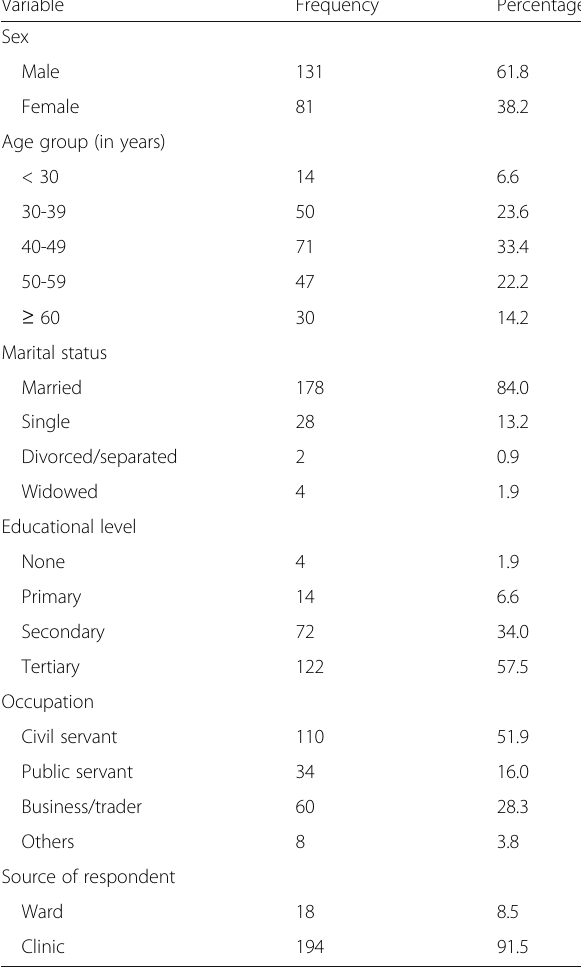
Table 1 Sociodemographic characteristics of respondents ( N = 212) Calabar, Nigeria